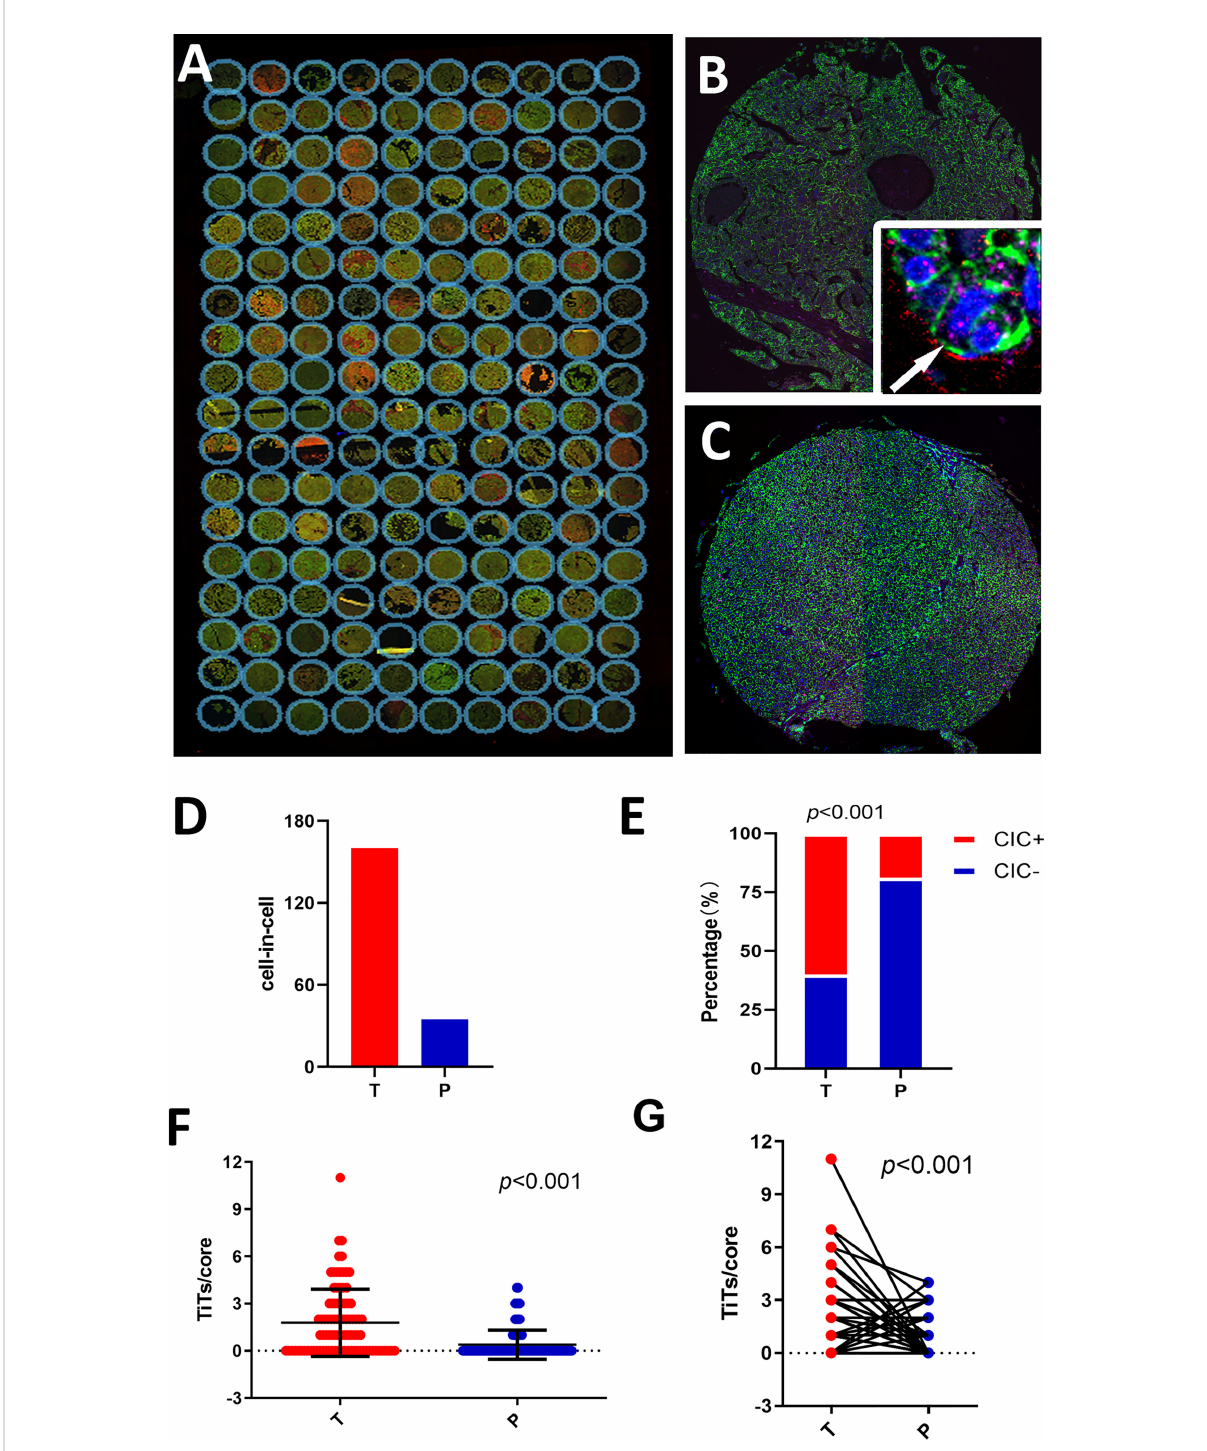
FIGURE 1 Detecting homotypic CICs in a tissue microarray (TMA) of human HCC. (A) Composite images of a whole TMA slide stained with antibodies against E-cadherin (green), CD44 (red), CD45 (pink), and DAPI staining of the nucleus (blue). (B) Single representative tumor tissue (T) core. The arrow in the inserted image shows one typical CIC. (C) Para-tumor tissue core (P). (D) CIC counts in tumor and para-tumor tissues. (E) Percentages of patients with or without CICs in tumor and non-tumor tissues. (F) CICs detected in 90 tumor cores and paired para-tumor tissue cores. (G) CICs presented as number of CICs per core in the tumor and non-tumor